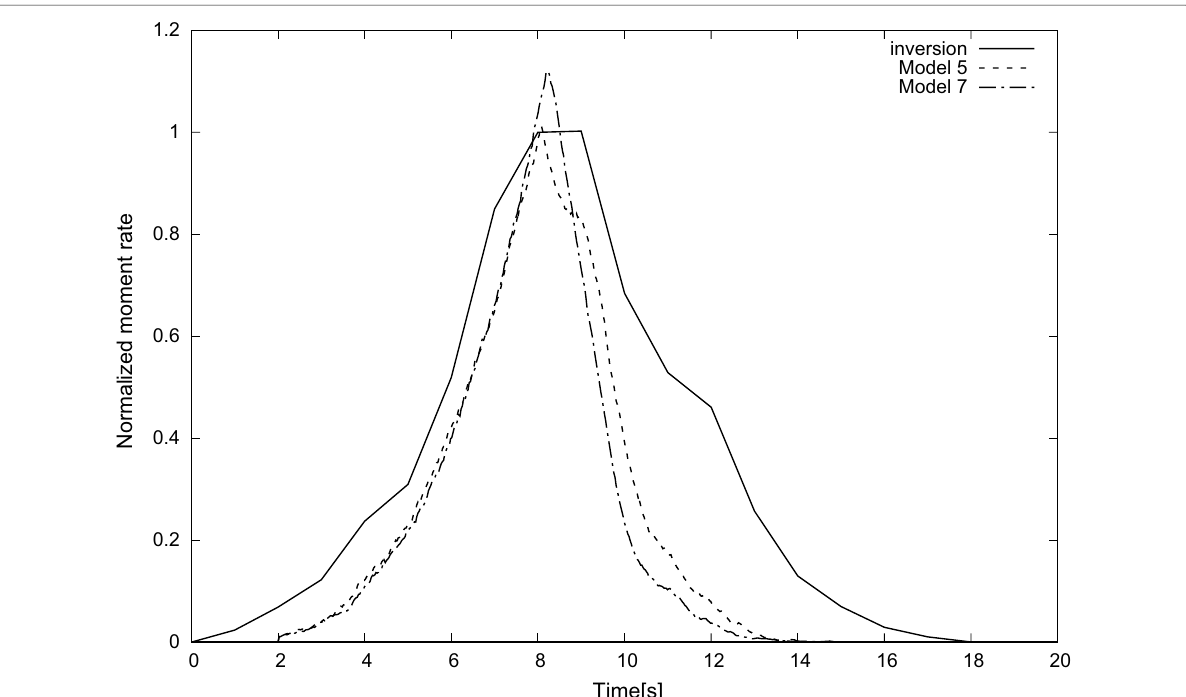
Fig. 8 Moment rate functions normalized by the peak values from the inversion (solid line) and the dynamic simulation (dashed lines) for Model 5, 7 as indicated. The values of Model 7 are normalized by the same factor with Model 5. The results of Model 5 and Model 7 are plotted 2 s behind the inversion result to compare their main peaks